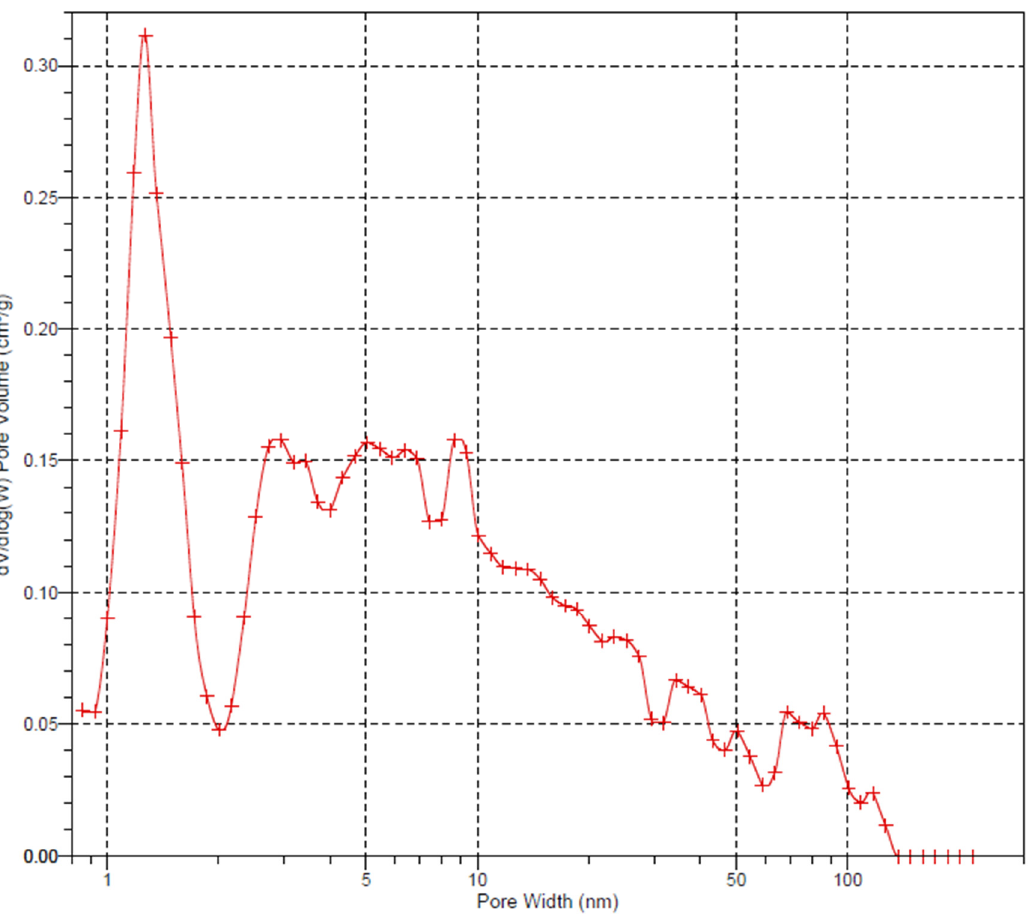
Figure 1. Pore size distribution by DFT model of commercial activated carbon. Table 2. Ultimate analysis of commercial activated